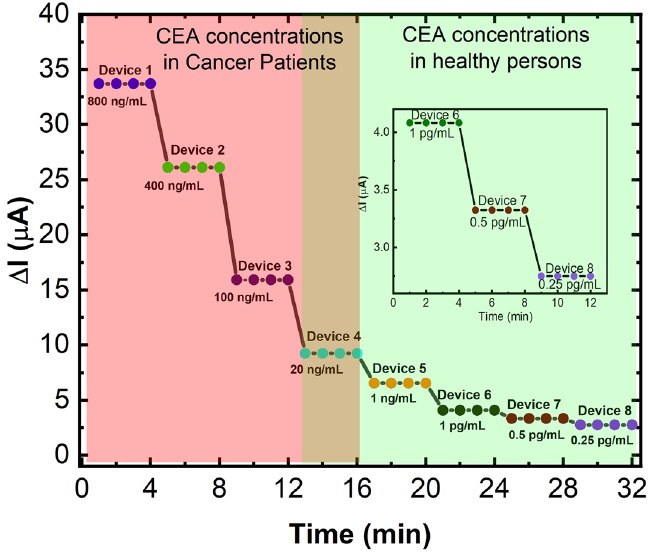
Figure 5. Response of anti-CEA/PhPTz/rGO sensors to 0.25 pg/mL to 800 ng/mL of CEA. Inset shows the response of the anti-CEA/PhPTz/rGO sensors to 0.25 pg/mL to 1 pg/mL of